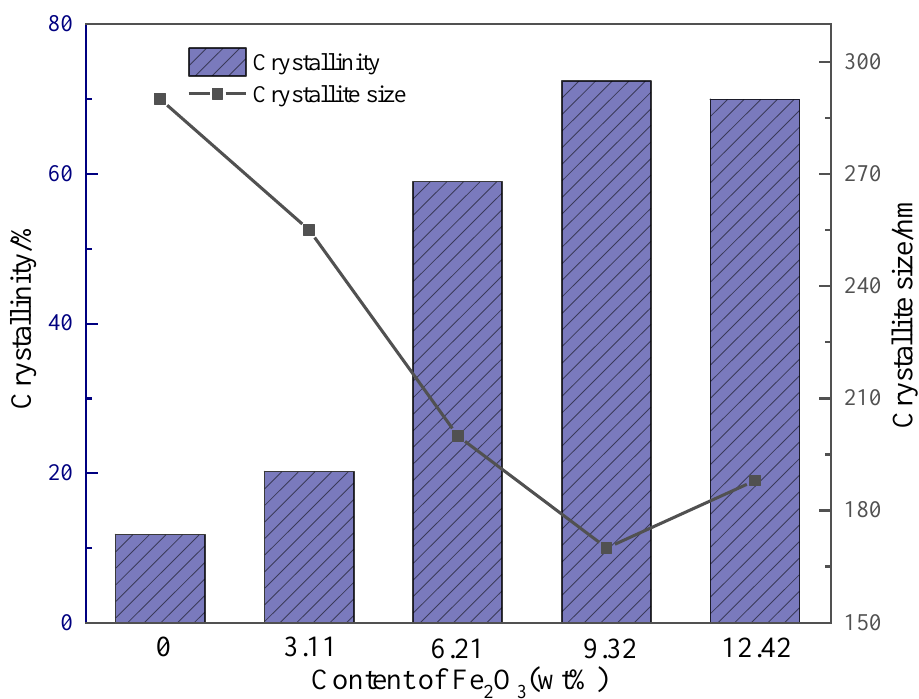
Figure 4. Crystallinity and crystallite size of glass-ceramics.